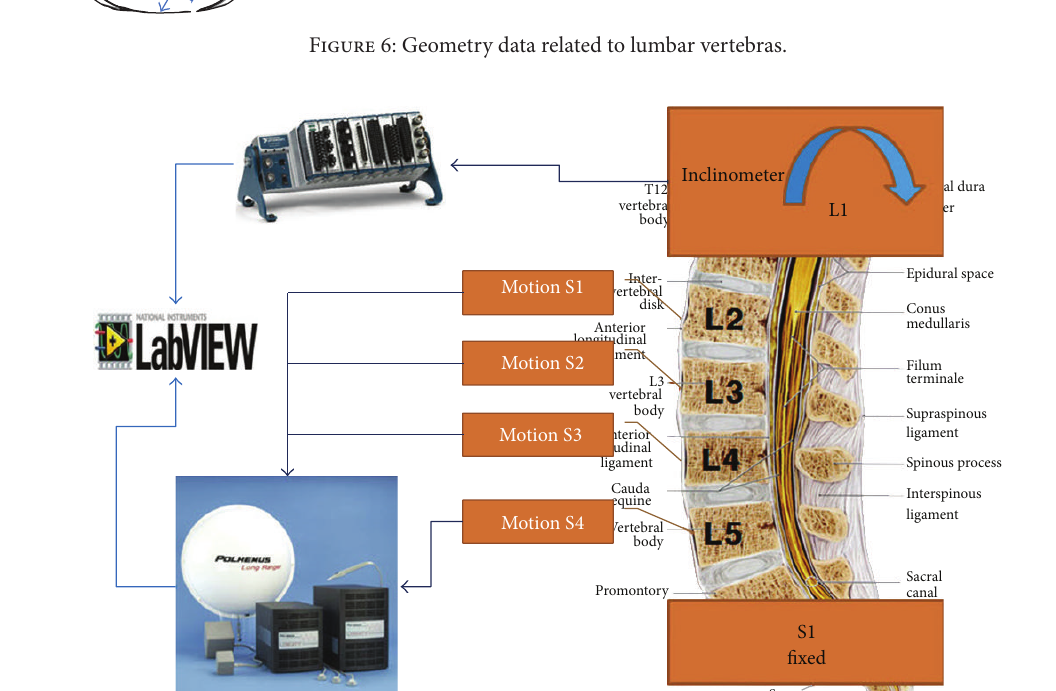
Figure 7: Testing devices for measuring property